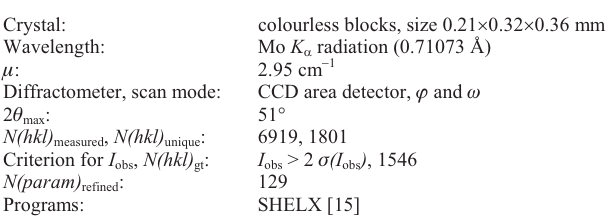
Table 1. Data collection and handling.